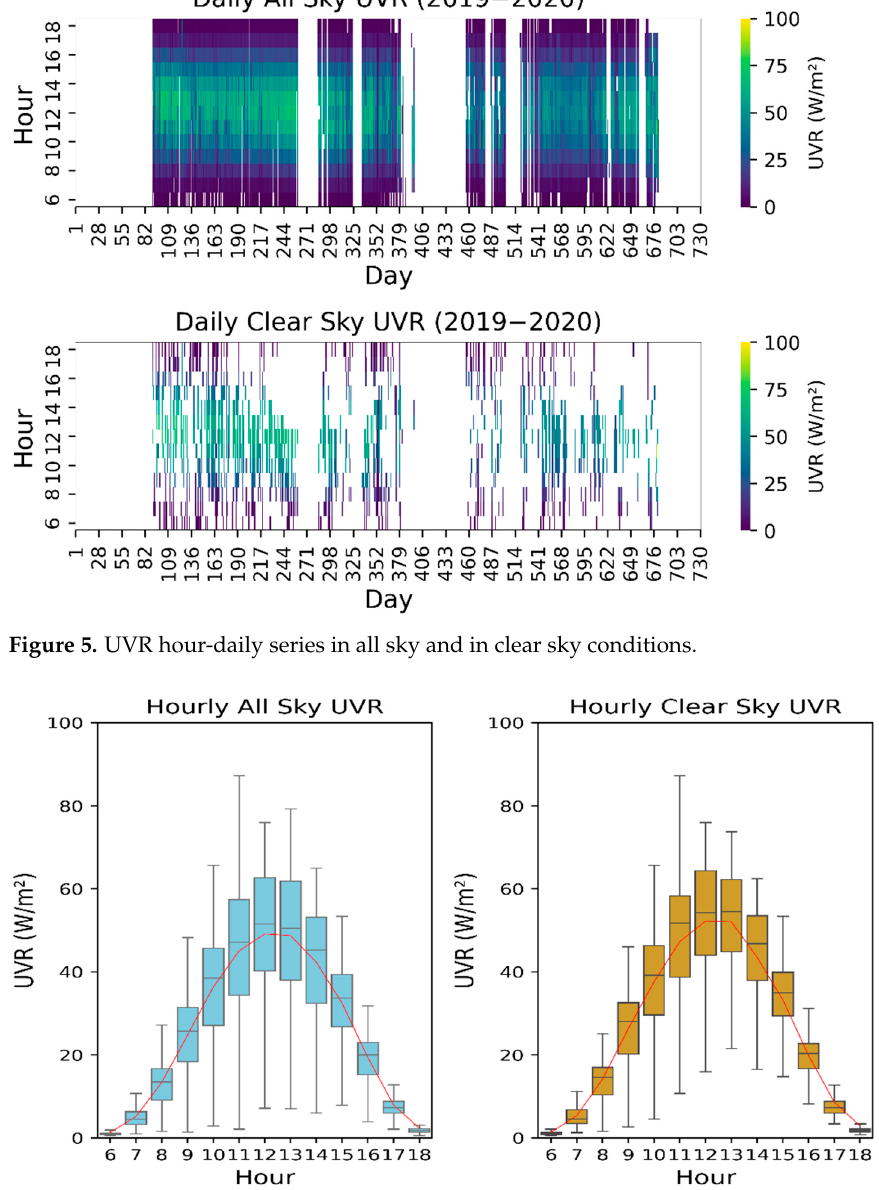
Figure 6. Hourly UVR variation under all sky and clear sky conditions, averaged over 2 years at Santarém.